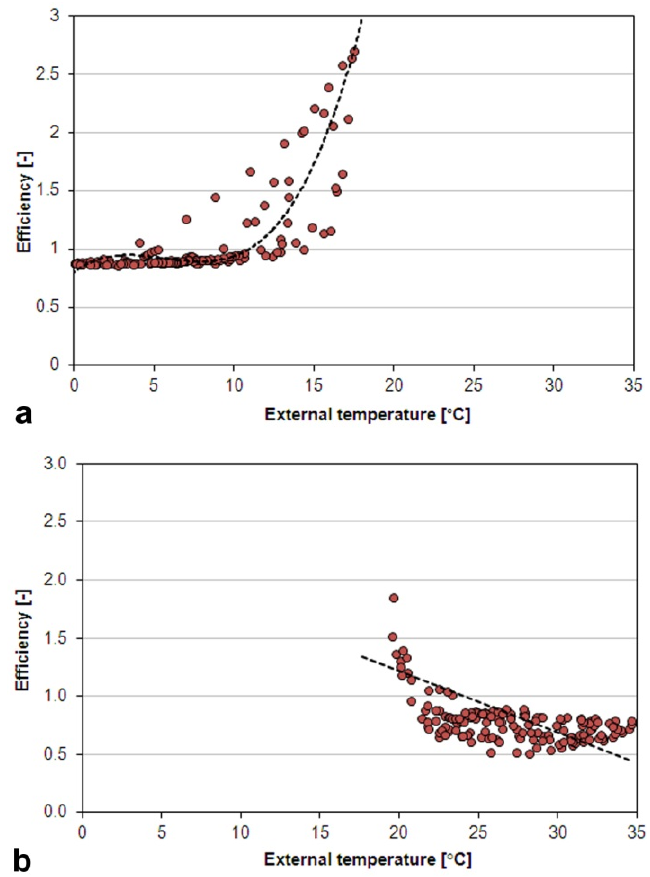
Figure 14. Behavior of energy efficiency of the system in function of: ( a ) external temperature below 20 °C; ( b ) external temperature above 20 °C.